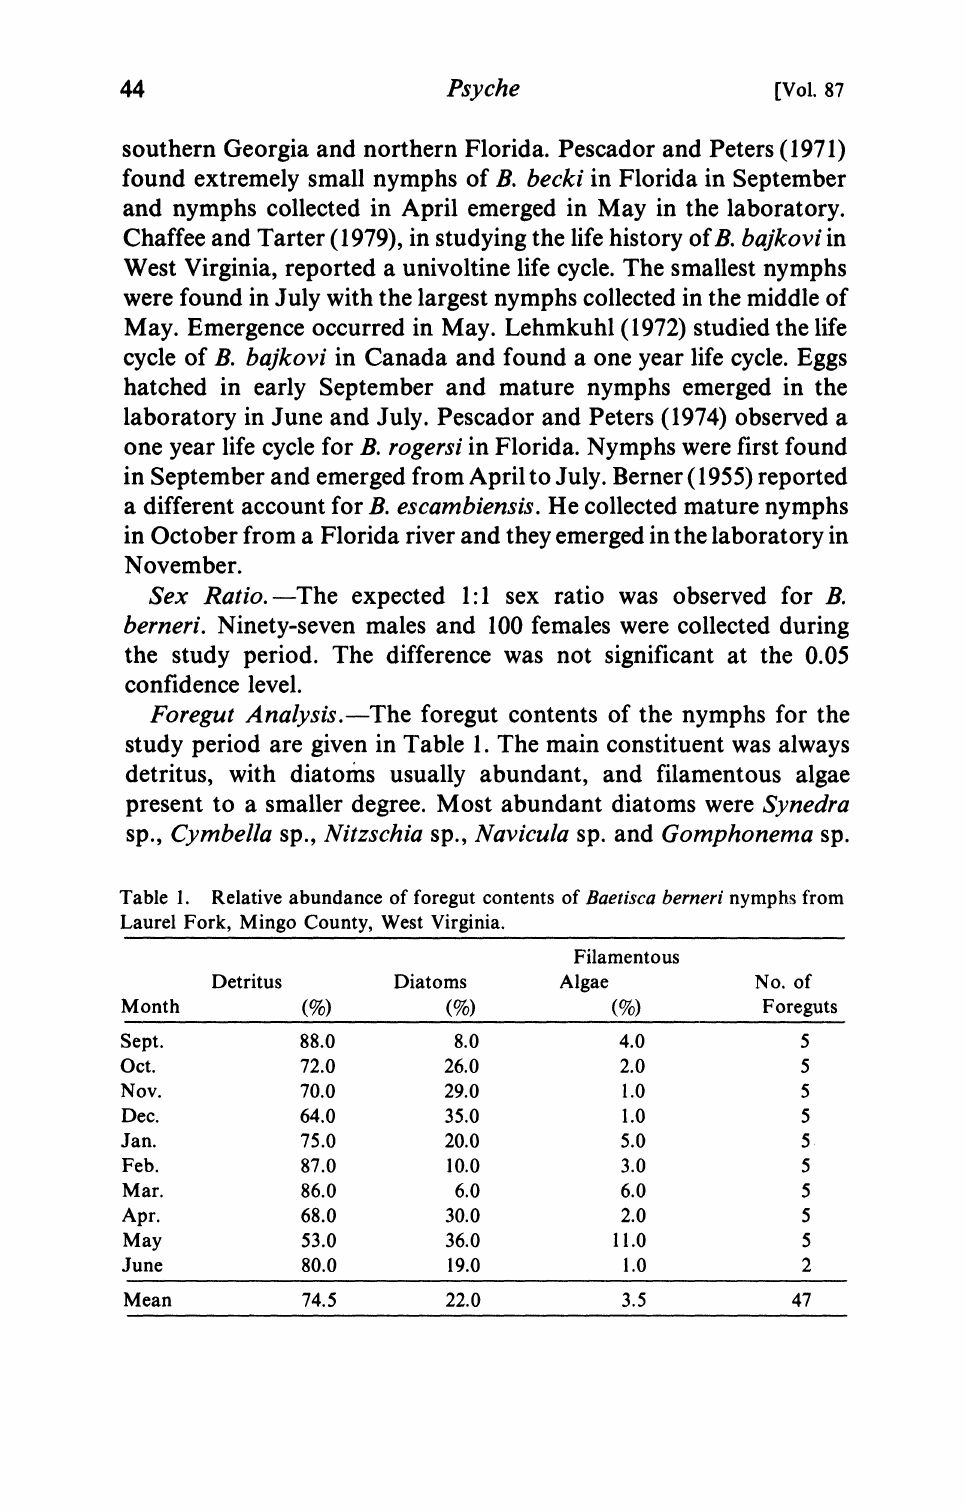
Table 1. Relative abundance of foregut contents of Baetisca berneri nymphs from Laurel Fork, Mingo County, West Virginia. Filamentous Detritus Diatoms